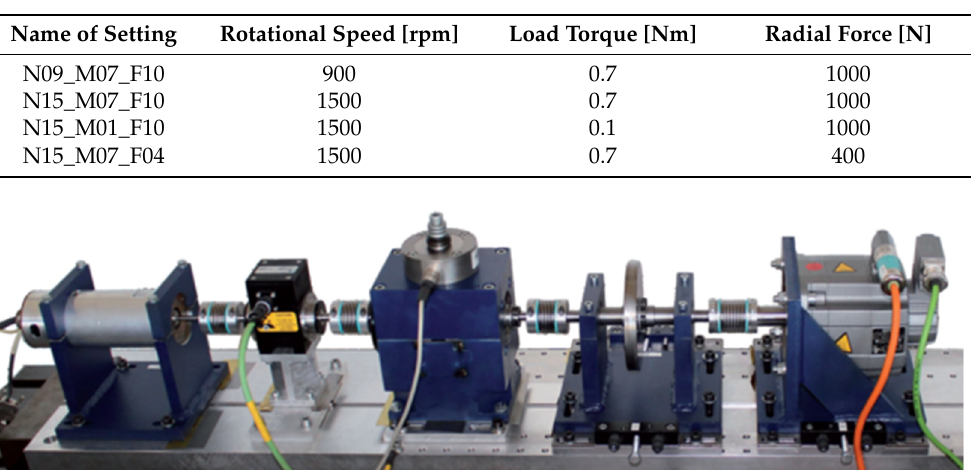
Table 1. Operating parameters.